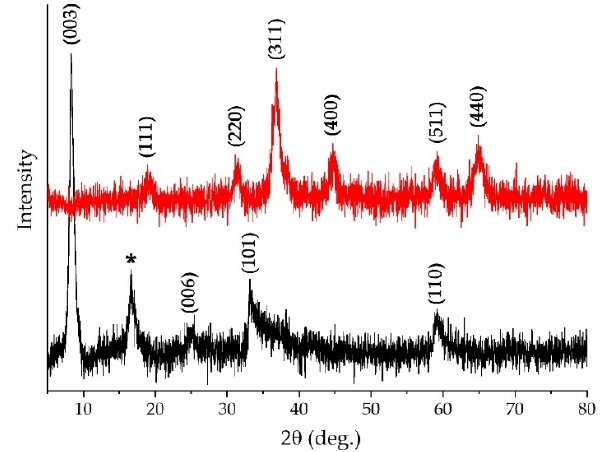
Figure 4. XRD patterns of the intermediate product (black) and the resulting NiCo 2 O 4 nanopowder (red). The “*” marker indicates a reflex referring to M(CO 3 ) 0.5 OH-0.11H 2 O (where M is nickel and cobalt cations).